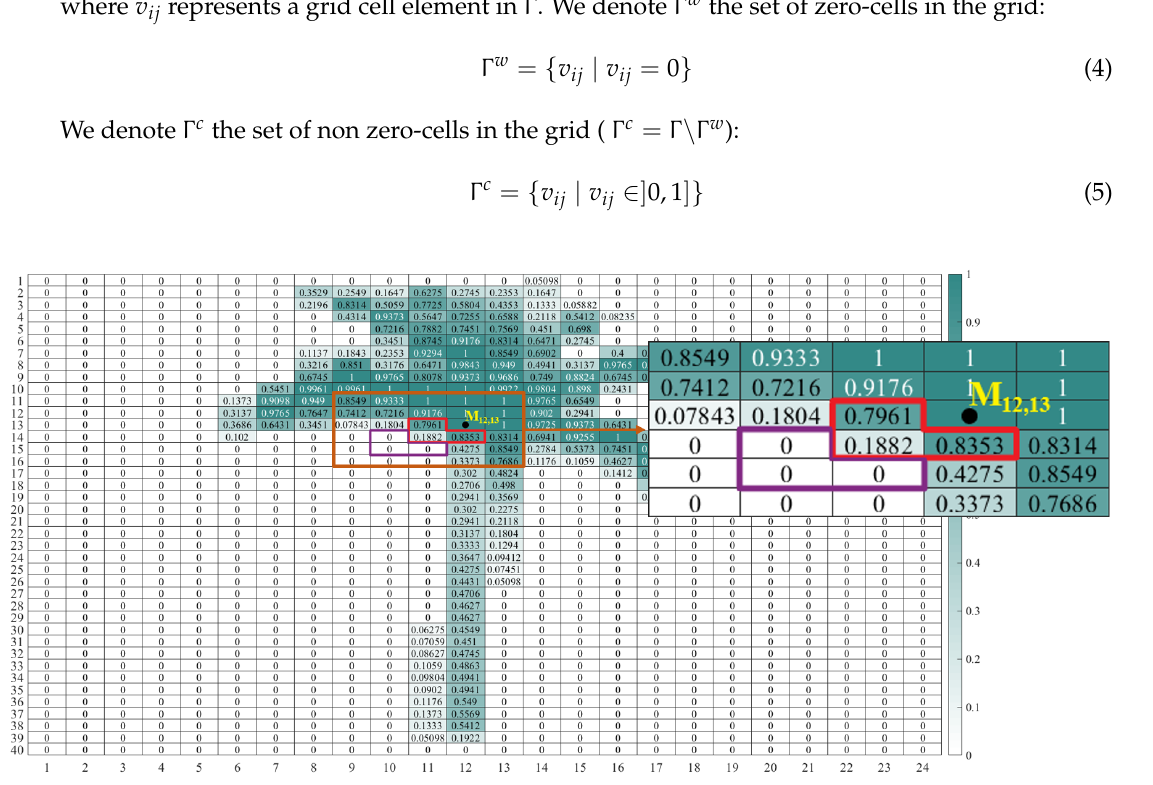
Figure 4. Example of a tree Heatmap in the frame. The drone position is (12, 13). The red box represents boundary cells, and the purple box represents solution